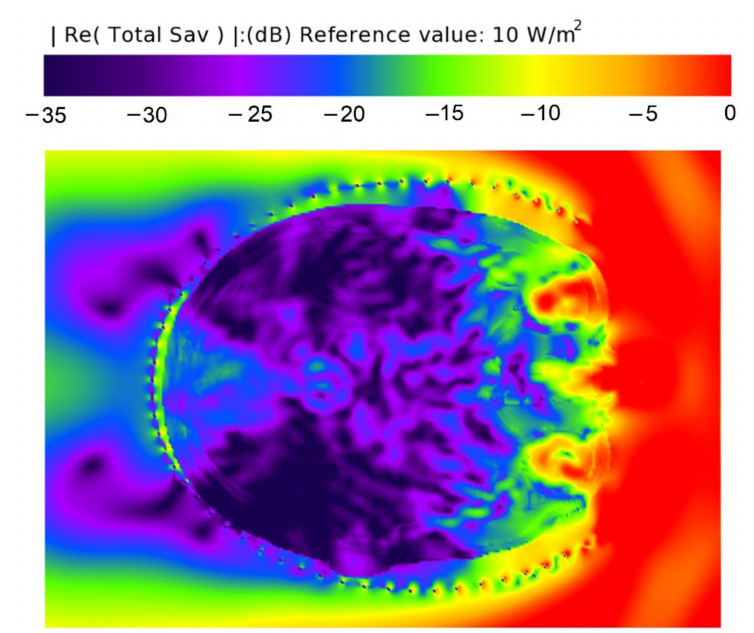
Figure 13. Power density for wire shield, 3600 MHz (in the logarithmic scale with reference value equal to 10 W/m 2